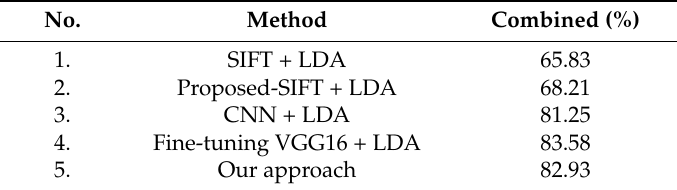
Table 3. The classification accuracy of different methods from the combined datasets.